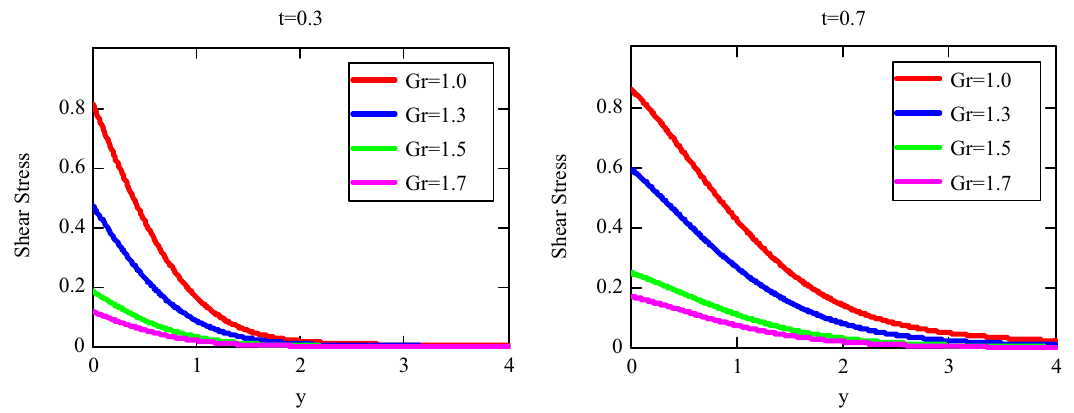
Figure 8: The shear stress for the variation of the Grashof